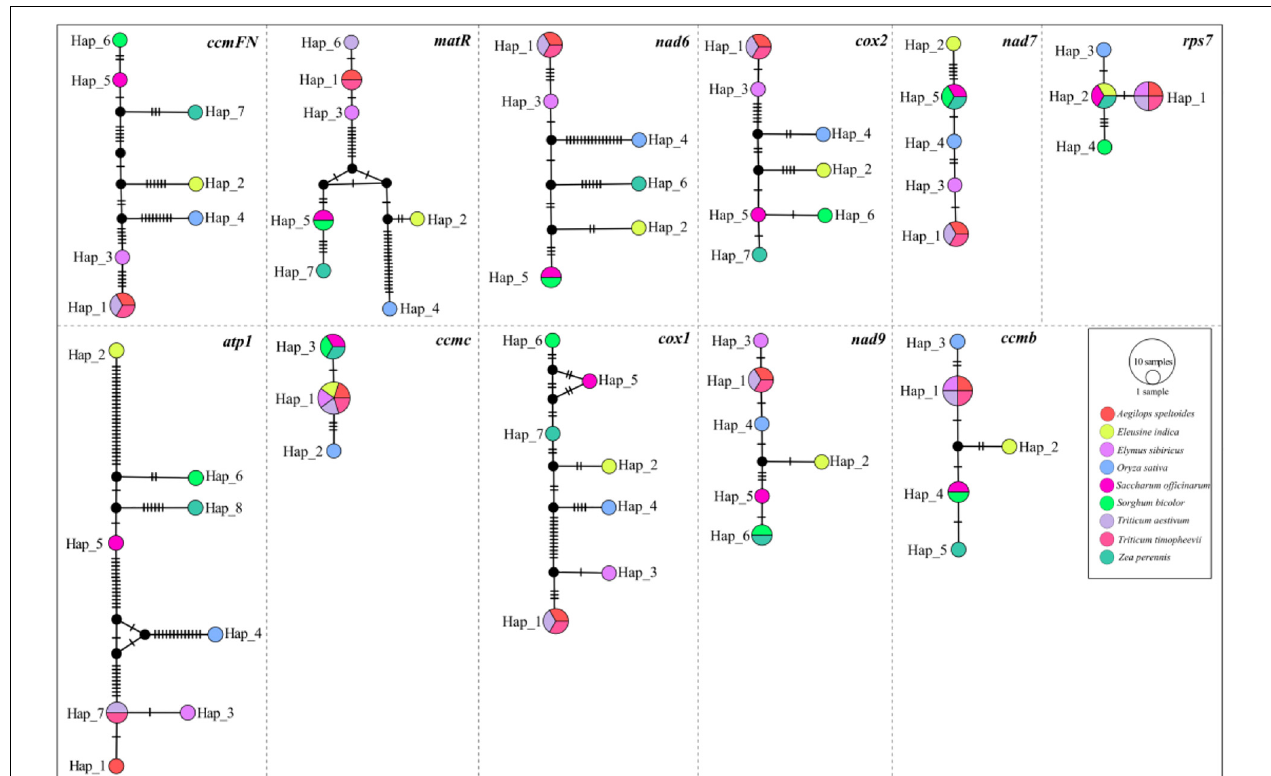
FIGURE 4 | Haplotype networks constructed using 11 shared genes between Gramineae mitogenomes.